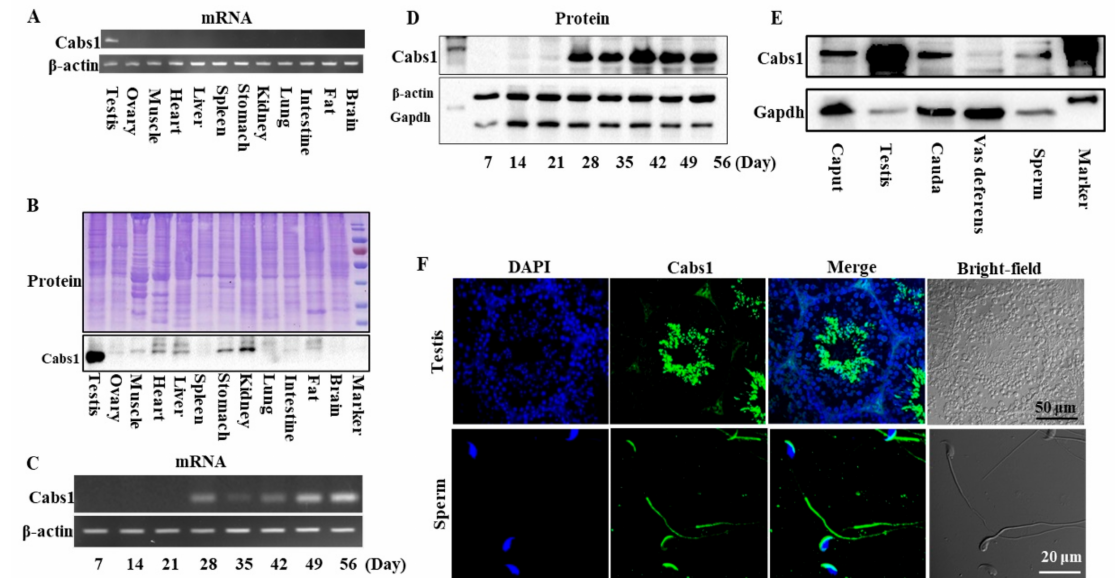
Figure 1. Temporal and spatial expression profiles of calcium-binding protein spermatid-associated 1 (Cabs1). ( A ) The mRNA and ( B ) protein expression of Cabs1 in the testis, ovary, muscle, heart, liver, spleen, kidney, lung, intestine, fat, and brain. ( C ) mRNA and ( D ) protein expression of Cabs1 in the testis at different stages of development. Total RNA was isolated from samples using a RNAiso Plus kit, and RT-PCR was performed to detect Cabs1 expression levels. β -actin gene expression was used as a loading control. ( E ) Protein expression of Cabs1 in the caput and cauda epididymis, vas deferens, and mature sperm. Equal amounts of total protein were subjected to SDS-PAGE and immunoblot analysis with antibodies directed against Cabs1, β -actin, and Gapdh. The blots are representative of three independent experiments. β -actin and Gapdh were used as the internal references. ( F ) Localization of the Cabs1 protein in mouse testis and sperm. Immunofluorescence labeling of frozen sections of mouse testis and mature sperm with the Cabs1 antibody and nuclear staining with DAPI (4 (cid:48) ,6-Diamidino-2-Phenylindole, Dihydrochloride). Imaging was performed on a confocal